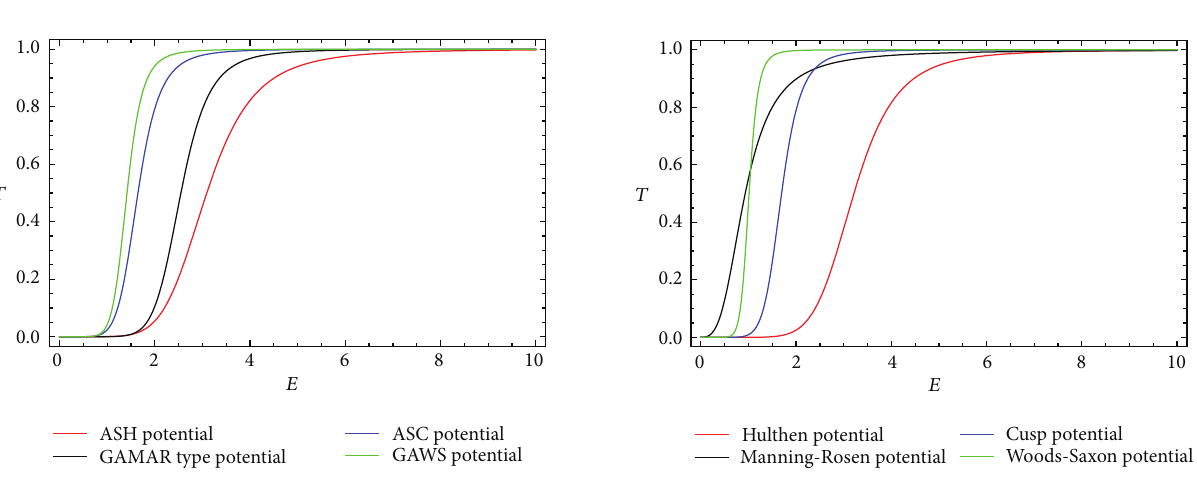
Figure 5: The effect of the asymmetric potentials on the transmis- Figure6: Theeffectofthepotentialsonthetransmissioncoefficient: ̃Λ = 1 , sion coefficient: the ASH potential for 𝛼 = 0.5 , 𝛽 = 0.8 , 𝑥 0 = ̃𝑥 0 = 0 , the Hulthen potential for 𝛼 = 𝛽 = 0.5 , 𝑥 0 = ̃𝑥 0 = 0 , Λ = Λ = ̃Λ = 1 , Δ = ̃Δ = −0.5 , 𝐴 = 𝐶 = 0 , 𝐵 = 𝐷 = 2 , and 𝑚 = 1 , the Δ = ̃Δ = −0.5 , 𝐴 = 𝐶 = 0 , 𝐵 = 𝐷 = 2 , and 𝑚 = 1 , the Manning- ̃Λ = 1 ̃Λ = 1 , GAMAR potential for 𝛼 = 0.5 , 𝛽 = 0.8 , 𝑥 0 = ̃𝑥 0 = 0.5 , Λ = , Δ → −1 , Rosen potential for 𝛼 = 𝛽 = 0.5 , 𝑥 0 = ̃𝑥 0 = 0 , Λ = ̃Δ → −1 Δ = ̃Δ = 0.5 , 𝐴 = 𝐵 = 𝐶 = 𝐷 = 2 , and 𝑚 = 1 , the ASC potential , 𝐴 = 𝐵 = 0 , 𝐶 = 𝐷 = 2 , and 𝑚 = 1 , the Cusp potential ̃Λ = 1 ̃Δ → 0 ̃Λ = 1 ̃Δ → 0 , Δ → 0 , , for 𝛼 = 0.5 , 𝛽 = 0.8 , 𝑥 0 = ̃𝑥 0 = 0 , Λ = for 𝛼 = 𝛽 = 0.5 , 𝑥 0 = ̃𝑥 0 = 0 , Λ = , Δ → 0 , , 𝐴 = 𝐶 = 0 , 𝐵 = 𝐷 = 2 , and 𝑚 = 1 , and the GAWS potential for 𝐴 = 𝐶 = 0 , 𝐵 = 𝐷 = 2 , and 𝑚 = 1 , and the Woods-Saxon potential ̃Λ = 1 ̃Δ = 0.5 = ̃𝑥 = 0.5 , Λ = ̃Λ = 1 , Δ = ̃Δ = 0.5 , 𝐴 = 𝐶 = 0 , 𝛼 = 0.5 , 𝛽 = 0.8 , 𝑥 , Δ = , 𝐴 = 𝐶 = 0 , for 𝛼 = 𝛽 = 0.5 , 𝑥 0 = ̃𝑥 0 = 0.5 , Λ = 0 0 𝐵 = 𝐷 = 2 , and 𝑚 = 1 . 𝐵 = 𝐷 = 2 , and 𝑚 = 1